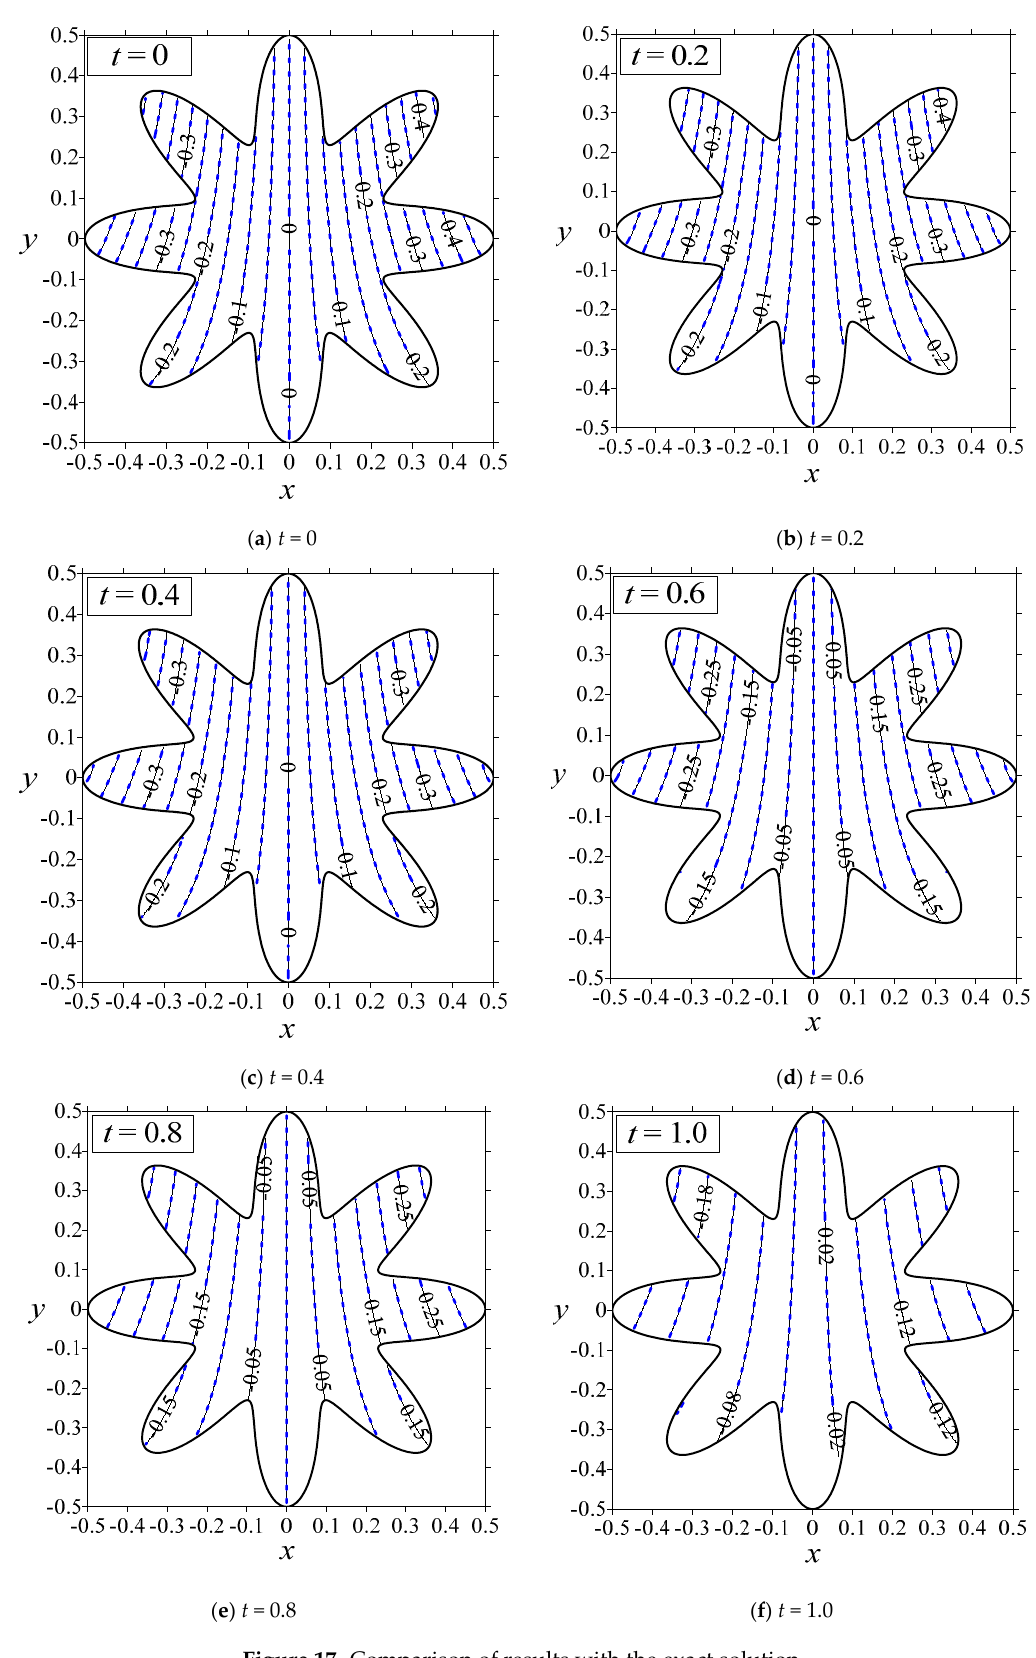
Figure 17. Comparison of results with the exact solution.